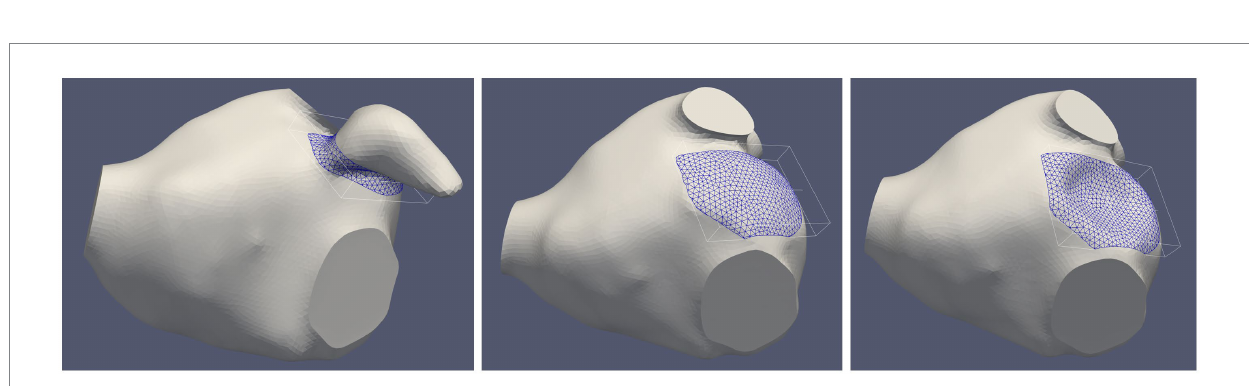
FIGURE 2 Selected volume near the surface of the implanted device in a representative patient before the occlusion (left panel) and after left atrial appendage occlusion (LAAO) with the “pacifier” device (middle panel) and with the “plug” device (right panel). The size of the volume in this patient was 1.54 cm 3 (average volume in the five patients: 1.50 ± 0.29 cm 3